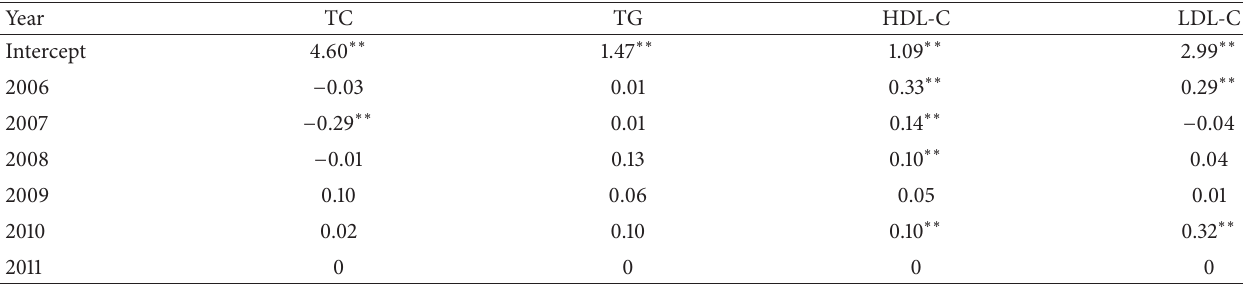
Table 3: Fixed coefficients of each blood lipid index of Chinese civil aviators in linear mixed-effect model by year 2006–2011 ( 𝑁 = 305 ).